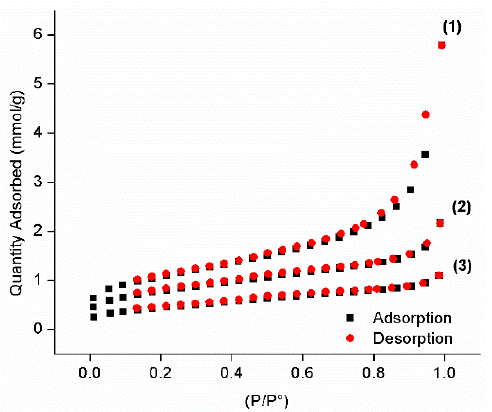
Figure 2. N 2 adsorption–desorption isotherms of SiO 2 @ZrO 2 : (1) 0.04 M; (2) 0.06 M; (3) 0.08 M of zirconium (IV) butoxide precursor calcined at 700 °C.